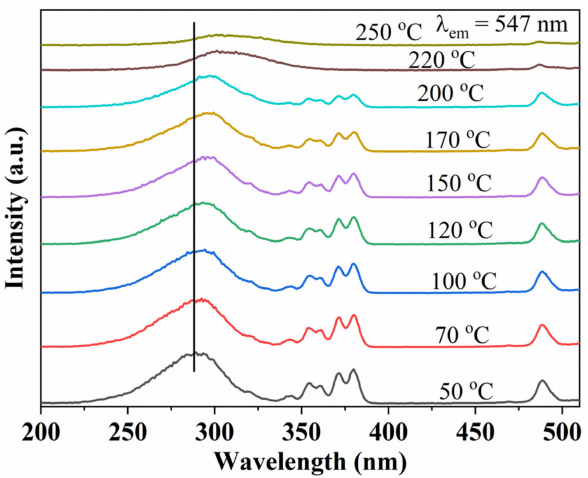
Figure 11. Measuring of temperature-dependent PL excitation spectra of Tb 3+ -doped Lu 2 Mo 3 O 12 phosphor prepared at 1000 ◦